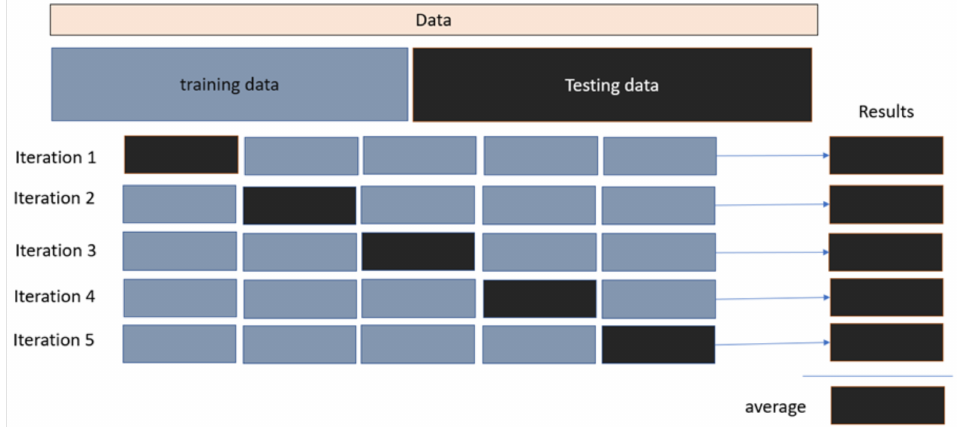
Figure 7. The cross validation for training and testing